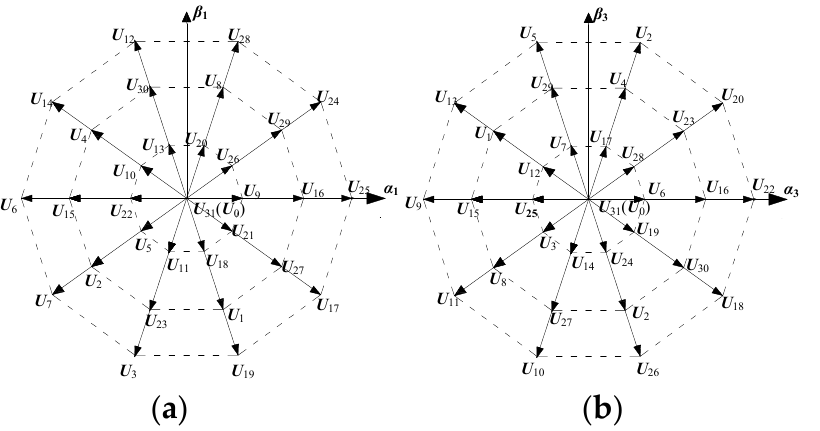
Figure 3. Voltage vectors distribution of five − phase VSI: ( a ) in fundamental subspace, ( b ) in harmonic subspace.